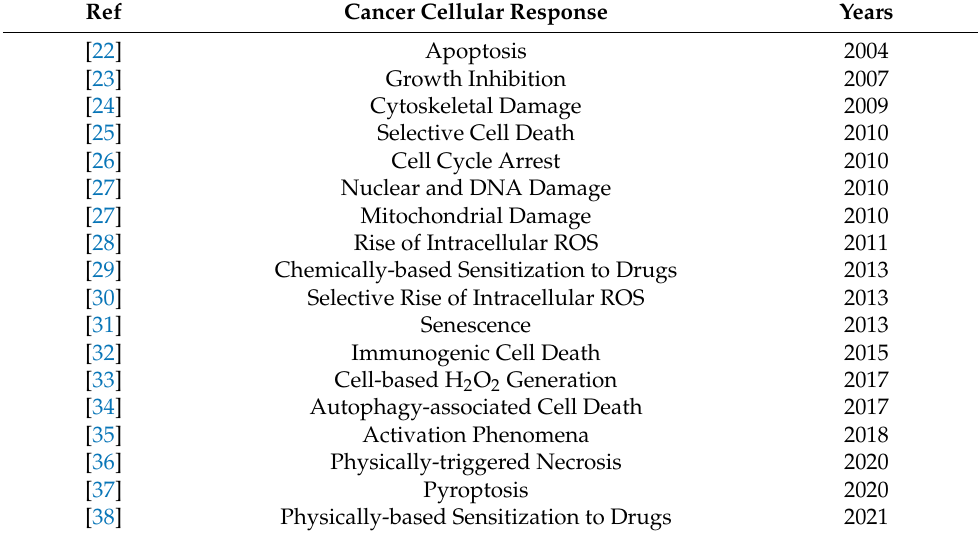
Table 1. Basic cancer cellular responses of CAP treatment in